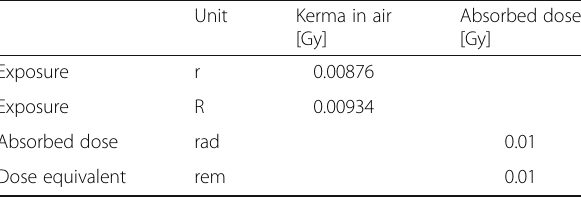
Table 4 Conversions of old quantities into ‘ kerma in air ’ or